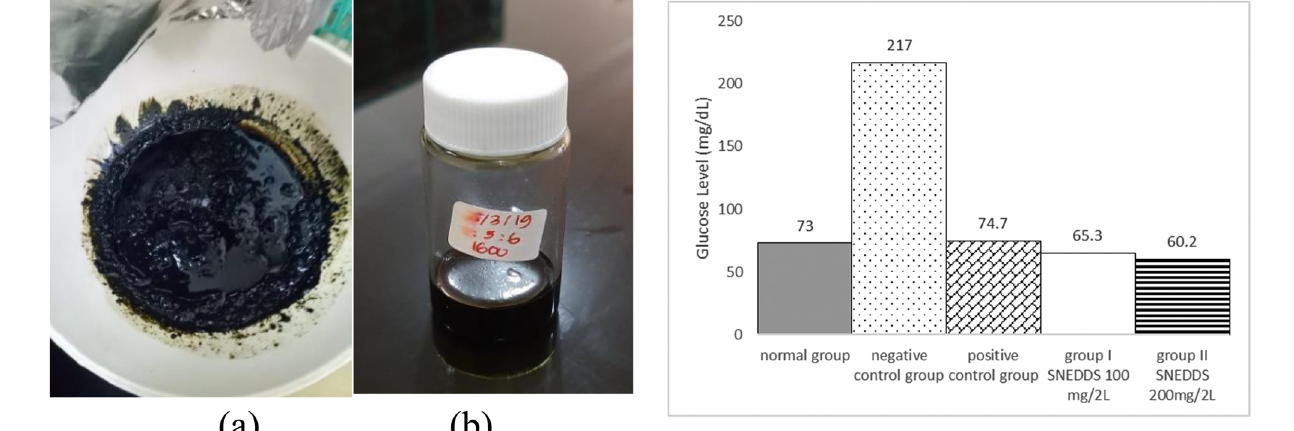
Figure 1: ( a ) PLE and ( b ) PLE SNEDDS.